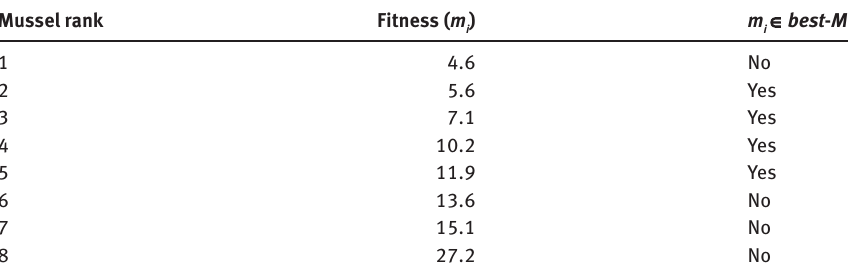
Table 7: Example for Determination of the best - M Subset. Mussel rank